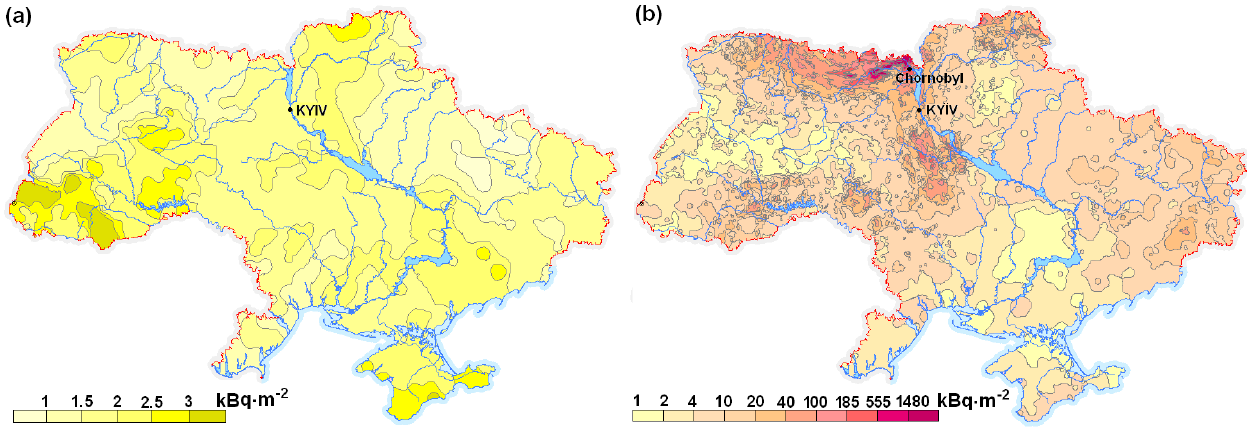
Figure 1. Maps of radioactive contamination of Ukraine by Cesium-137: (a) before-accident pollution (July 1985); (b) pollution after the Chornobyl accident (January 1998) (from Atlas of radioactive contamination of Ukraine (electronic version),